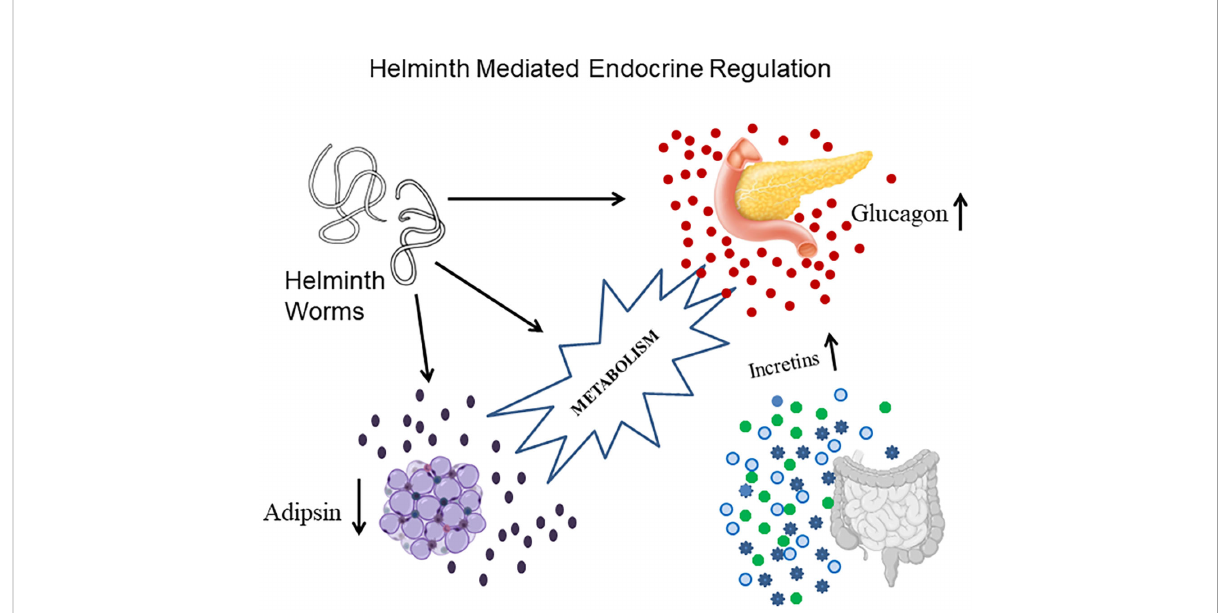
FIGURE 3 A model showing the complex endocrine regulation brought about by active helminth infection. Helminth infection increase the secretion of a) Glucagon from pancreas; b) Incretins from gut and c) Adipsin from adipose tissue. The bene fi cial effect of helminth infection in conferring protection against MS seems to be largely mediated through incretin